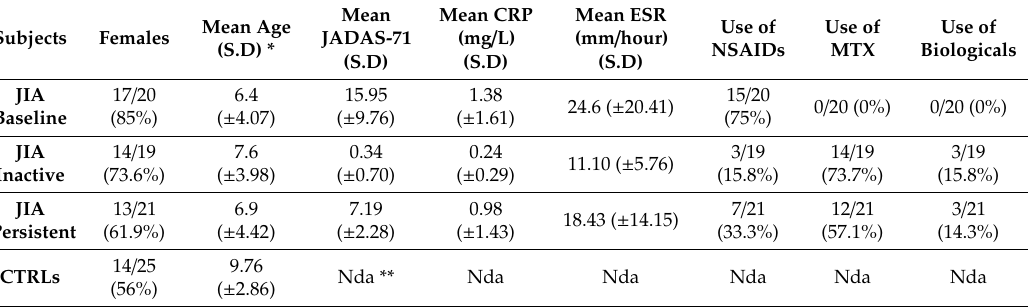
Table 1. Clinical characteristics of the patients with JIA and CTRLs.